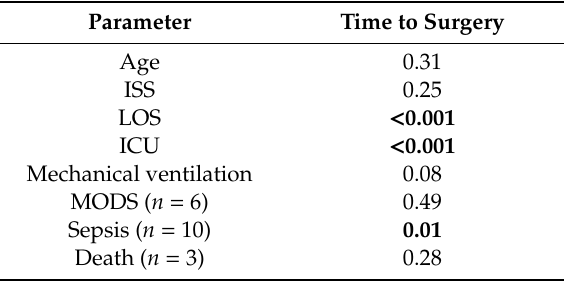
Table 6. Correlation analysis (Spearman) for time to surgery.